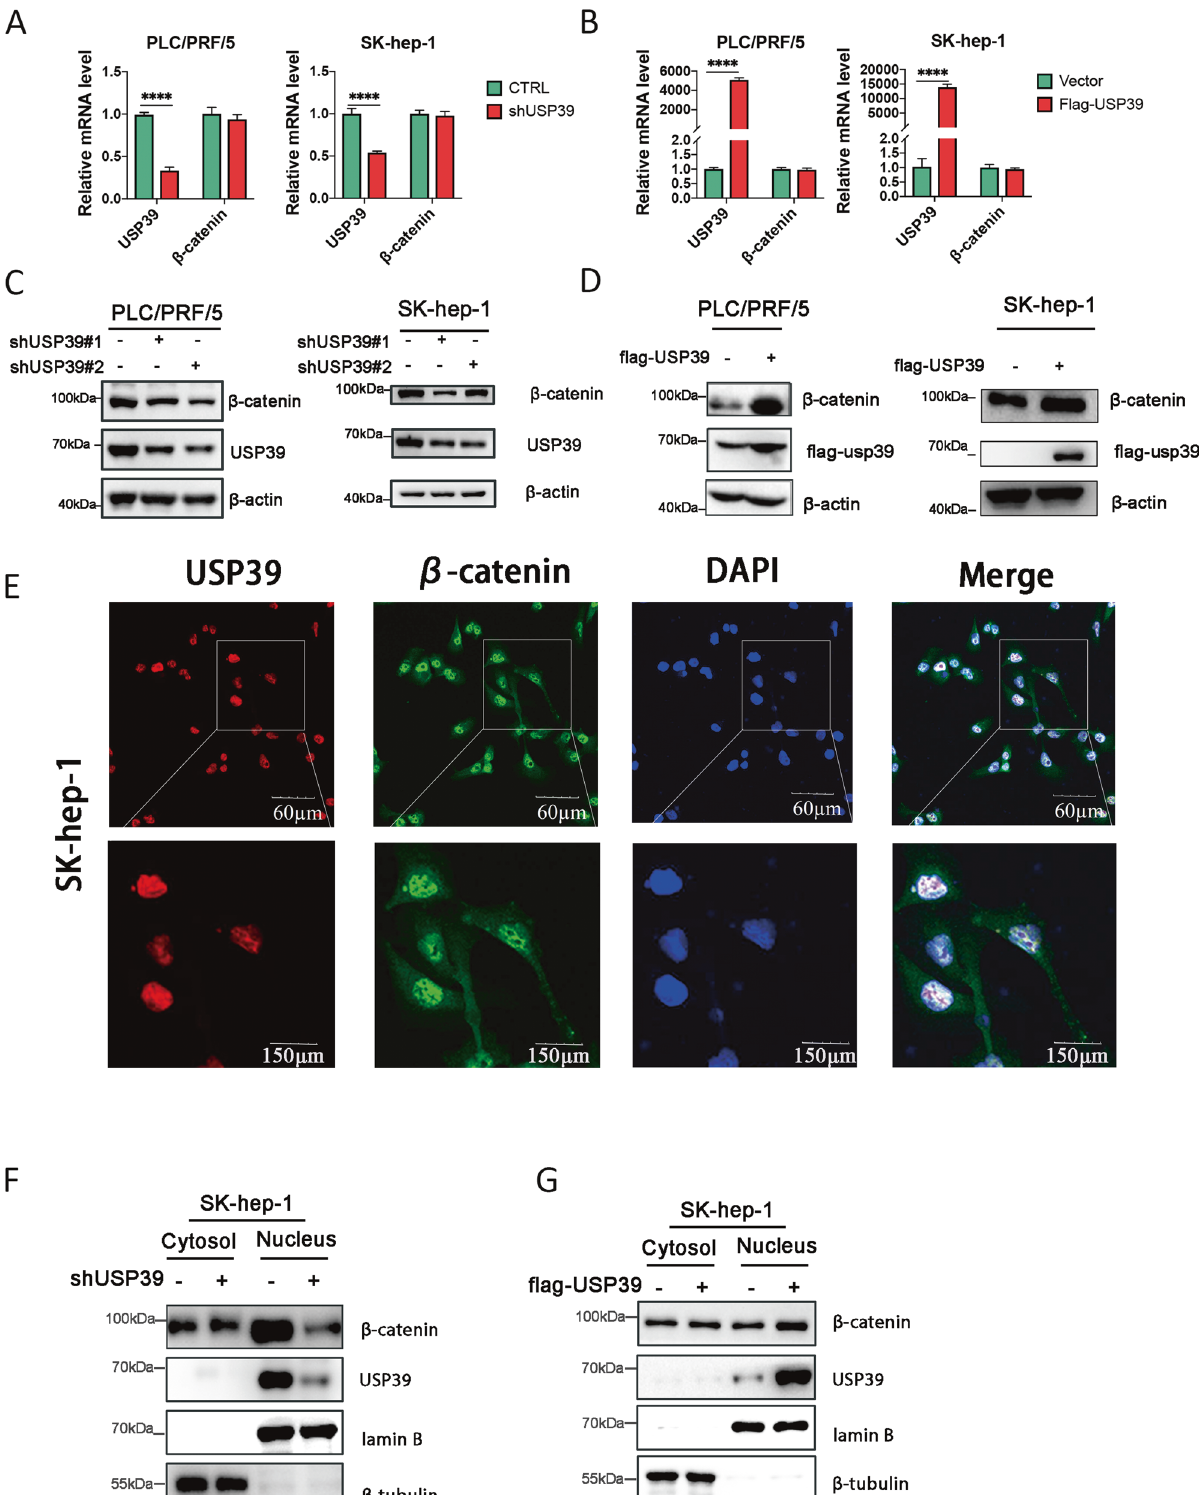
Fig. 2 USP39 affected β -catenin expression and localization. RT-PCR analyzed the impact of knockdown ( A ) and overexpression ( B ) of USP39 on transcription levels of β -catenin. Western blotting detects the expression of β -catenin after cells were knockdown ( C ) and overexpression ( D ) of USP39. E Immuno fl uorescence staining assays of USP39 and β -catenin in HCC cells (SK-hep-1) observed by confocal microscopy (scale bar = 60 μ m). Western blotting was performed to determine the distribution of β -catenin proteins in the nucleus and cytoplasm in SK-hep-1 after cells were knockdown ( F ) and overexpression ( G ) of USP39. All the data are representative of at least three independent experiments and presented as the means ± SD. (**** p < 0.0001 v.s. control by Student ’ s t -test).